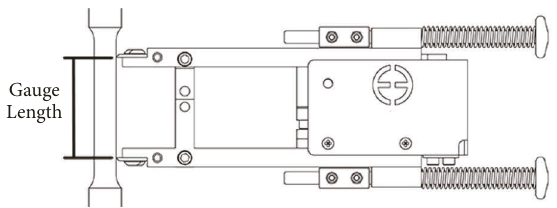
Figure 5: Extensometer with A50mm gauge length.